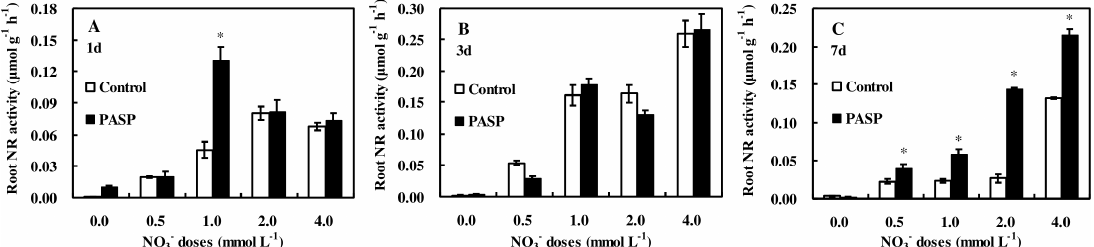
Figure 4. Changes in root nitrate reductase activities on the 1st ( A ), 3rd ( B ), and 7th ( C ) day after PASP treatment. The PASP and control indicate seedlings with and without PASP addition, respectively. Data were presented as the mean ± standard error of 15 plants in each treatment. *, Statistically significant differences between PASP treatment and control within each nitrogen level, according to Student’s test at p < 0.05.